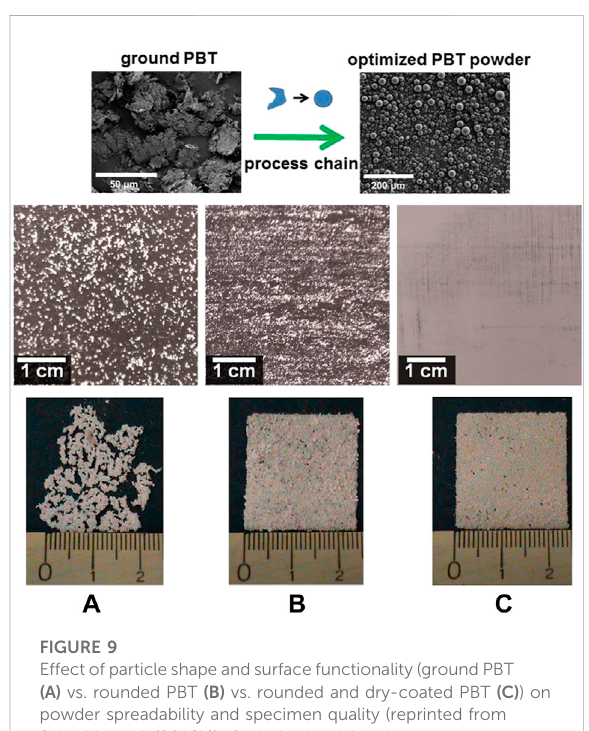
FIGURE 9 Effect ofparticleshape andsurfacefunctionality(ground PBT (A) vs. rounded PBT (B) vs. rounded and dry-coated PBT (C) ) on powder spreadability and specimen quality (reprinted from Schmidt et al. (2016b)), Optimized polybutylene terephthalate powders for selective laser beam melting. Chemical Engineering Science 156, 1 – 10, Copyright (2016), with permission from